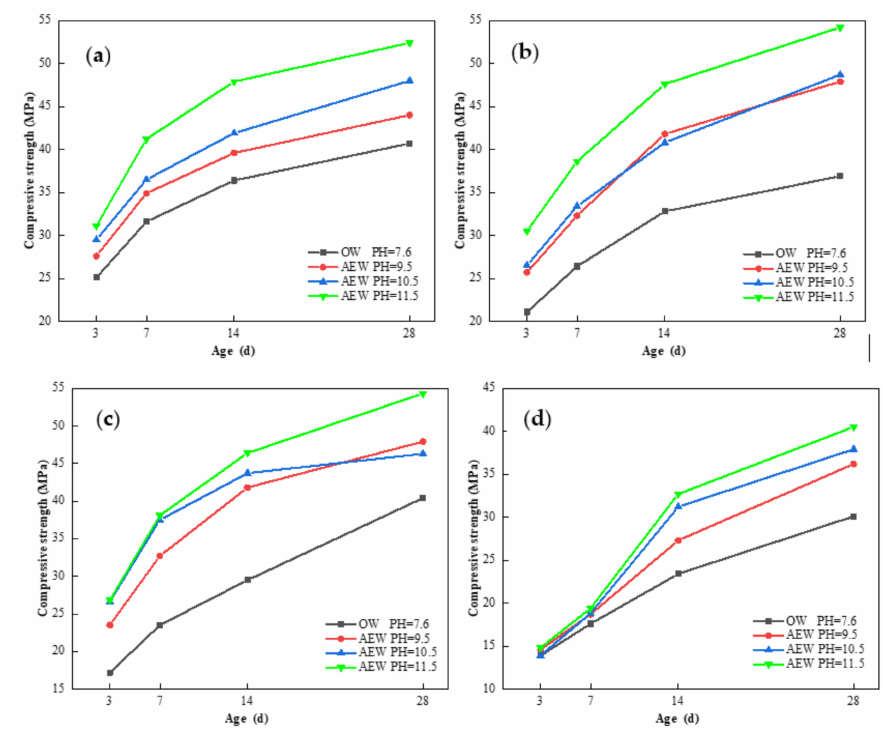
Figure 16. Effect of OW and AEW with different pH values on the compressive strength of FAM: ( a ) FA = 0; ( b ) FA = 15%; ( c ) FA = 30%; ( d ) FA =